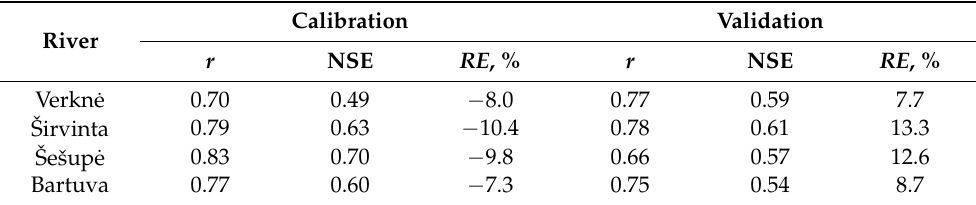
Table 2. Results of calibration and validation of hydrological